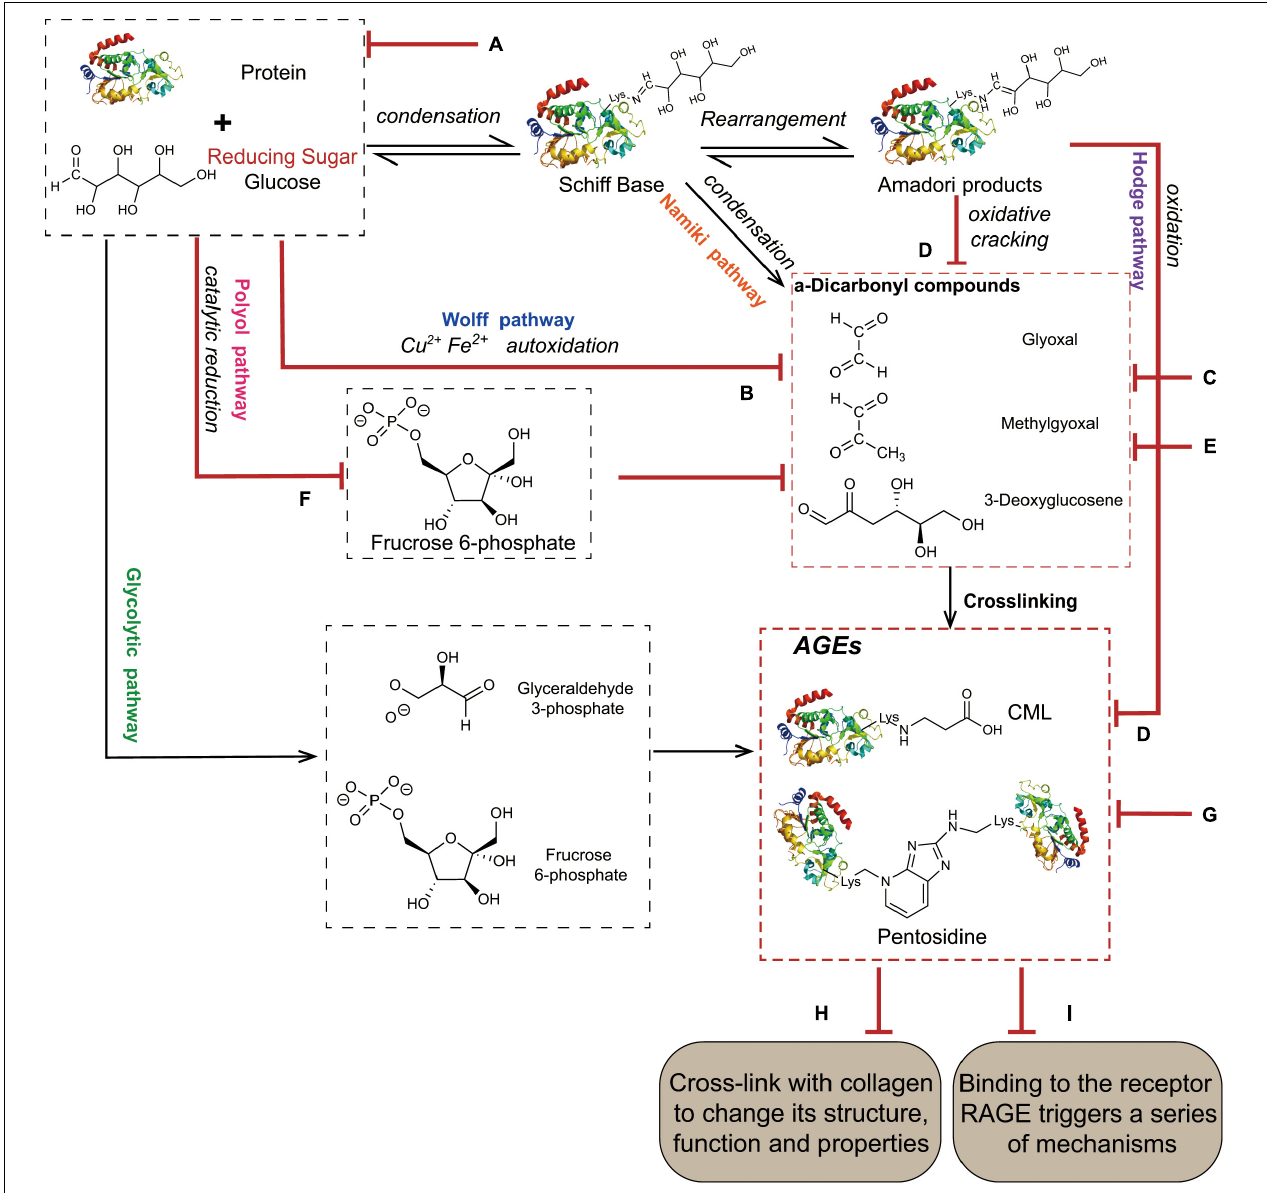
FIGURE 5 | The mechanisms of AGEs inhibition. (A) Maintain and stabilize the protein structure. (B) Chelation of transition metals. (C) Capture and block dicarbonyl compounds. (D) Neutralize, inhibit, and scavenge oxidative free radicals. (E) Activation of the glyoxalase detoxification system. (F) Inhibition of aldose reductase. (G) Activation of the proteolytic system. (H) Regulation of AGE-RAGE signal transduction. (I) Disruption of protein